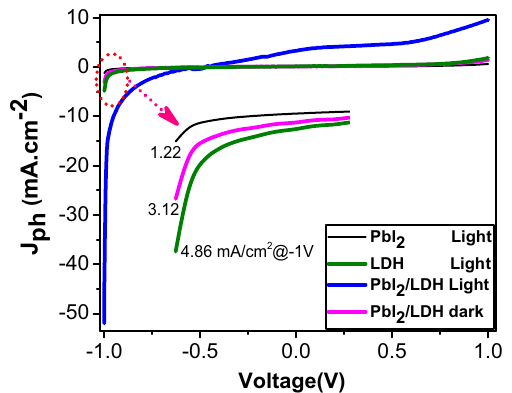
Figure 7. photocurrent density–voltage (J ph –V) curves of PEC reaction under dark and white light illumination using 0.3 M KOH utilizing PbI 2 , Co–Cd–Fe LDH, and T-LDH/PbI 2